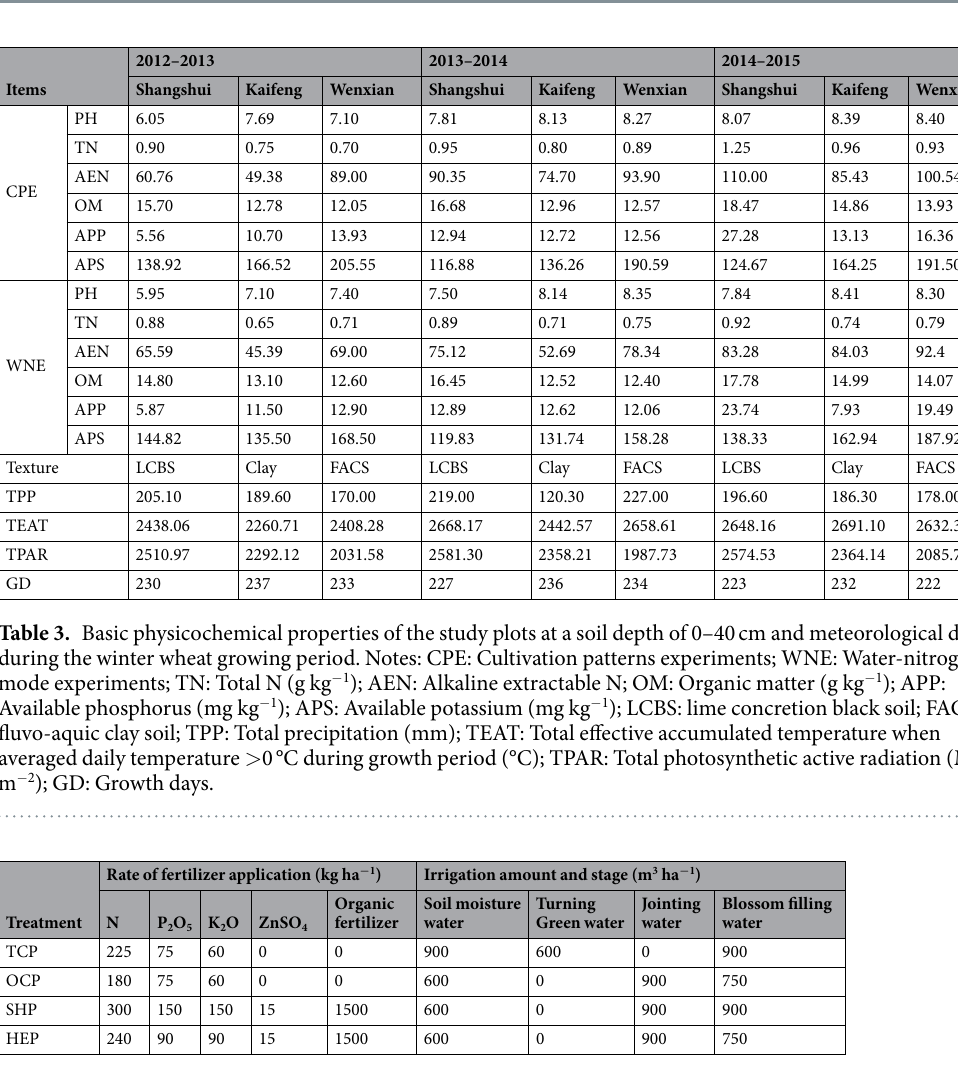
Table 4. Irrigation and fertilization management of the different cultivation patterns during the field experiments. Notes: TCP: Local farmers’ traditional cultivation pattern; OCP: Optimized cultivation pattern